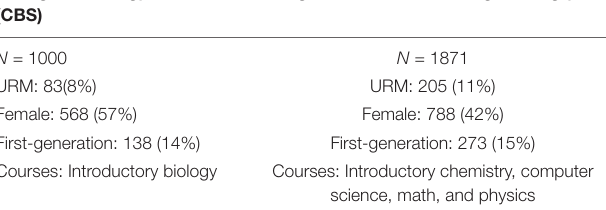
TABLE 3 | A descriptive demographic summary of the student sub-sample of who were surveyed for social psychological factors across the College of Biological Sciences (CBS) and the College of Science and Engineering